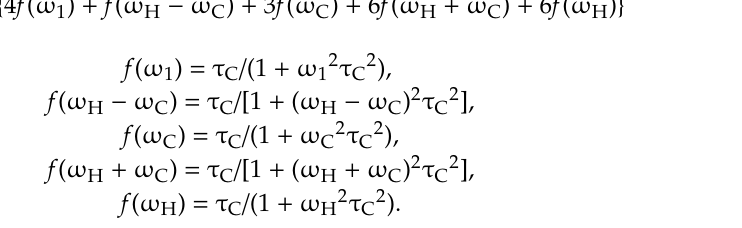
according to the delay times at 300 K).